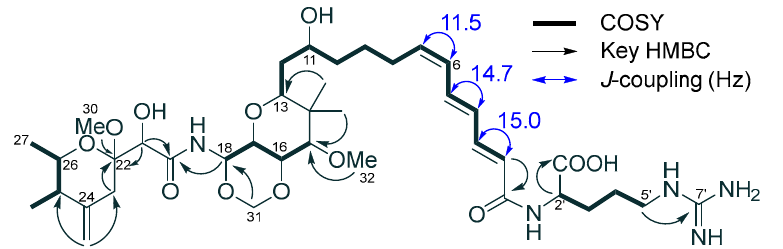
Figure 2. COSY, key HMBC cross-peaks and coupling constants of 6 Z -onnamide A ( 2 ). Table 2. NMR spectral data for 6 Z -onnamide ( 2 ) in CD 3 OD (400/150 MHz).